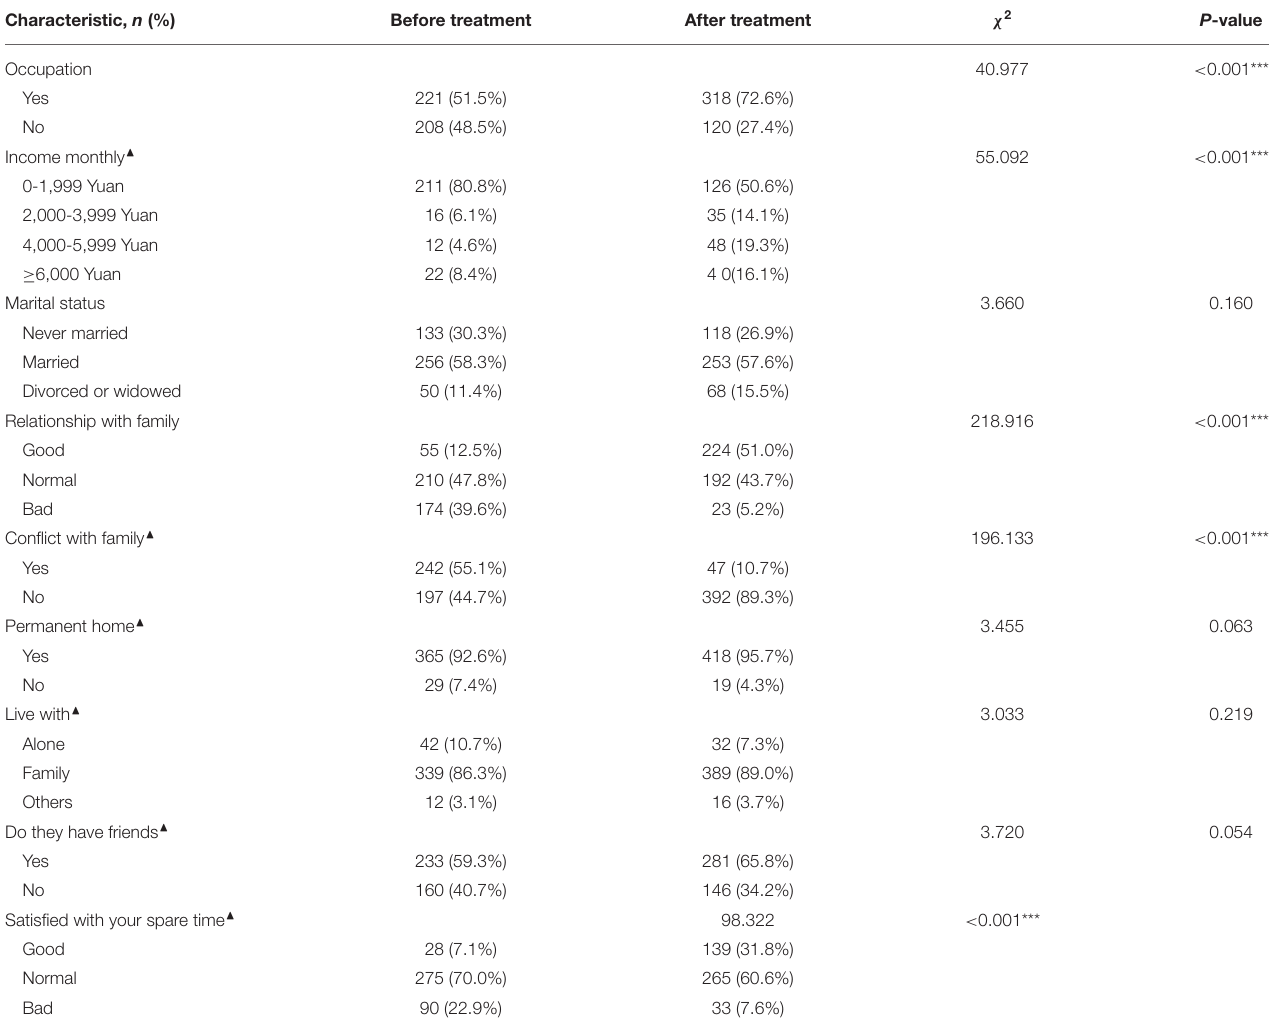
TABLE 3 | Comparison of related factors before and after rehab in VRCs. Characteristic, n (%) Before treatment After treatment χ